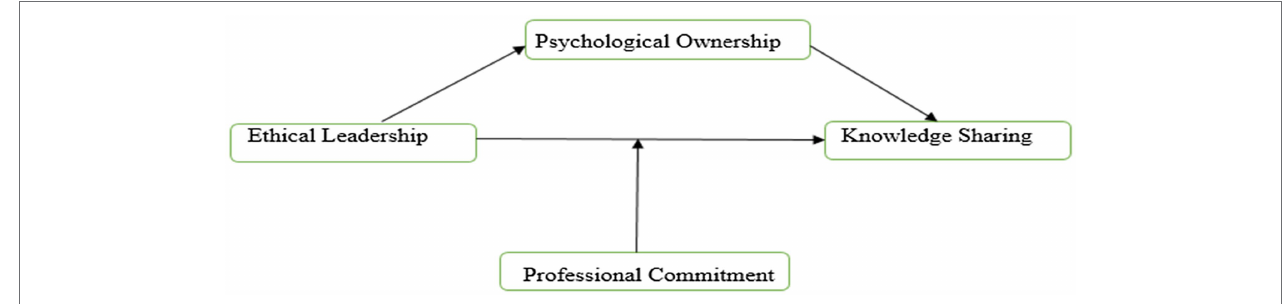
FIGURE 1 | Conceptual